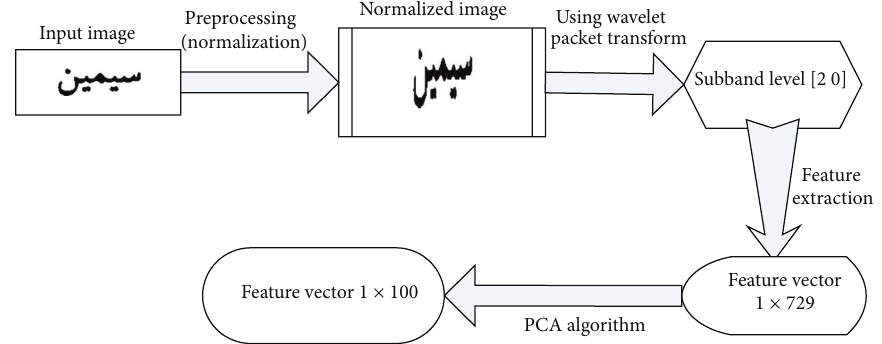
Figure 6: Feature extraction algorithm flow chart.